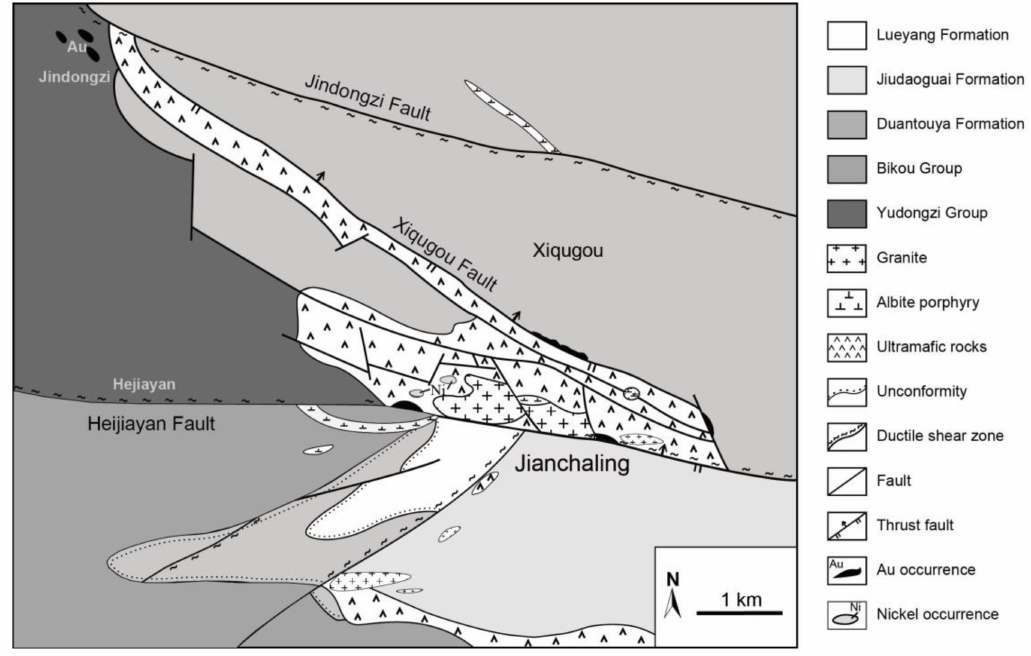
Figure 2. Geological sketch map of the Jianchaling Au deposit